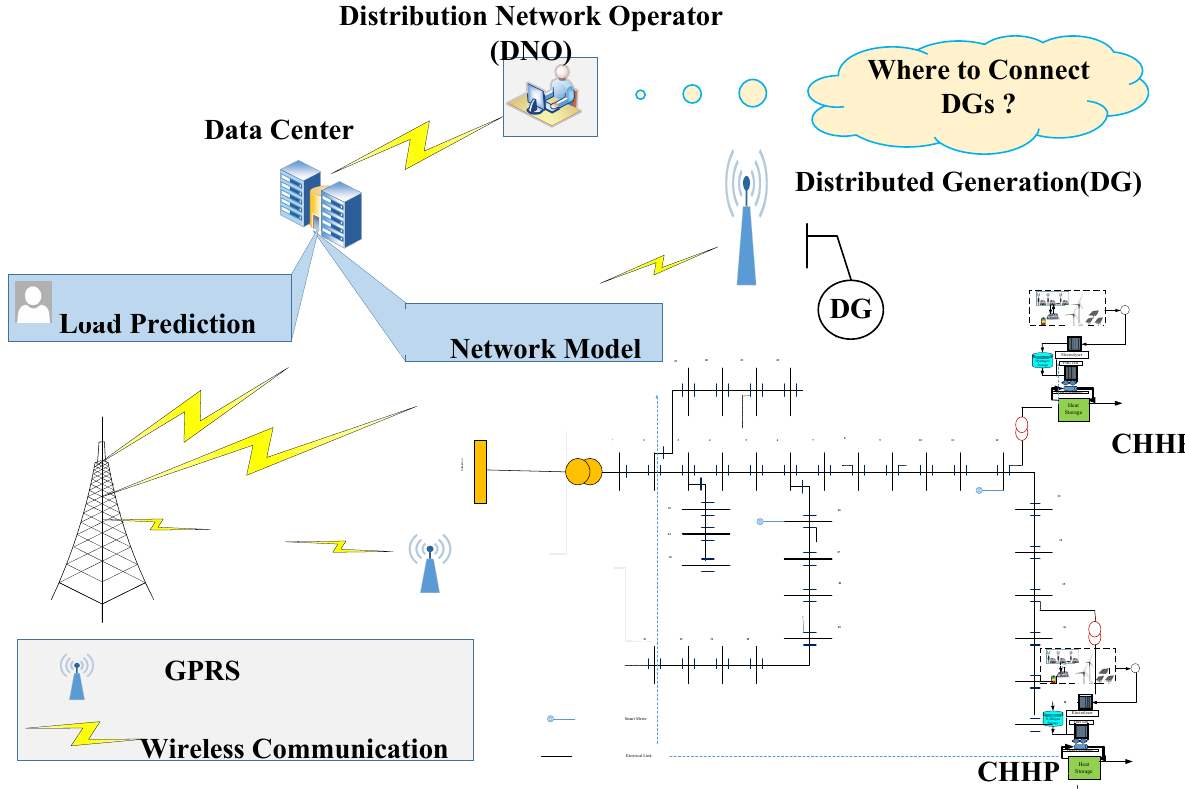
Figure 8. The proposed study system.